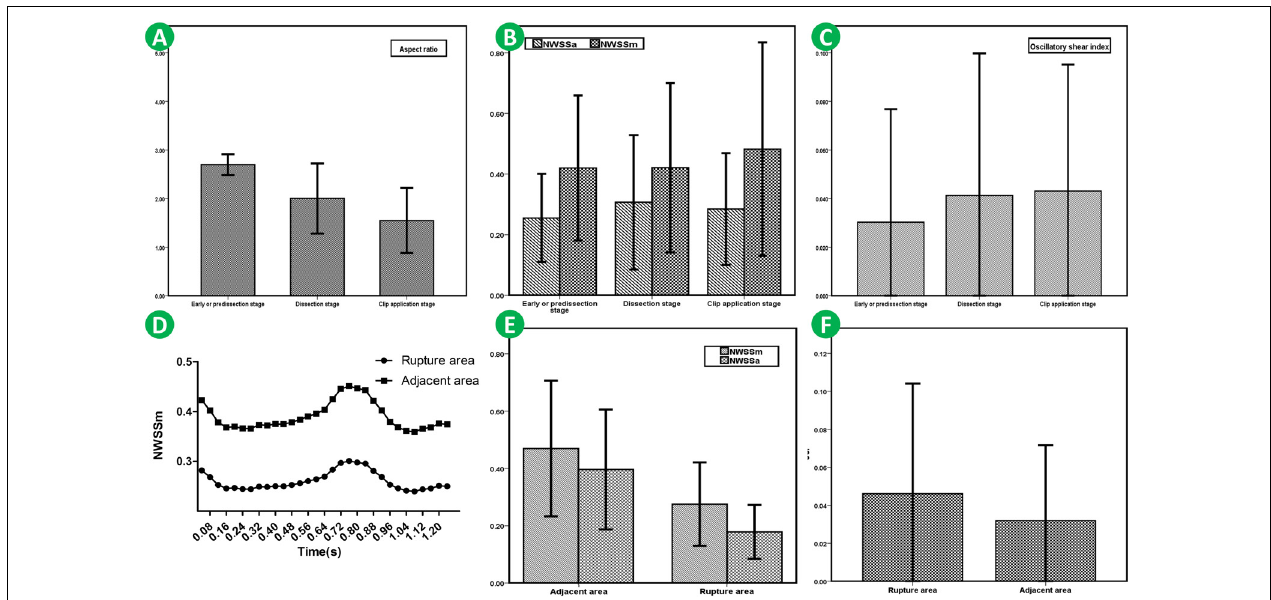
FIGURE 4 | AR for IAs ruptured in early or pre-dissection stage was much larger than that for IAs ruptured in dissection stage or clip application stage (A) . According to the trendency of NWSSm and NWSSa, with the decrease in WSS, the risk of early IOR (rupture before clip application) is higher. However, both NWSSa and NWSSm were very similar for IAs ruptured in dissection stage or clip application stage (B) . OSI for the IAs ruptured in early or pre-dissection stage seems lower than that for the IAs ruptured in other stages (C) . However, the difference is of no significance. NWSSa and NWSSm in rupture area were both lower than those in the adjacent area (D,E) . OSI in rupture area appears to be higher than that in adjacent area (F)